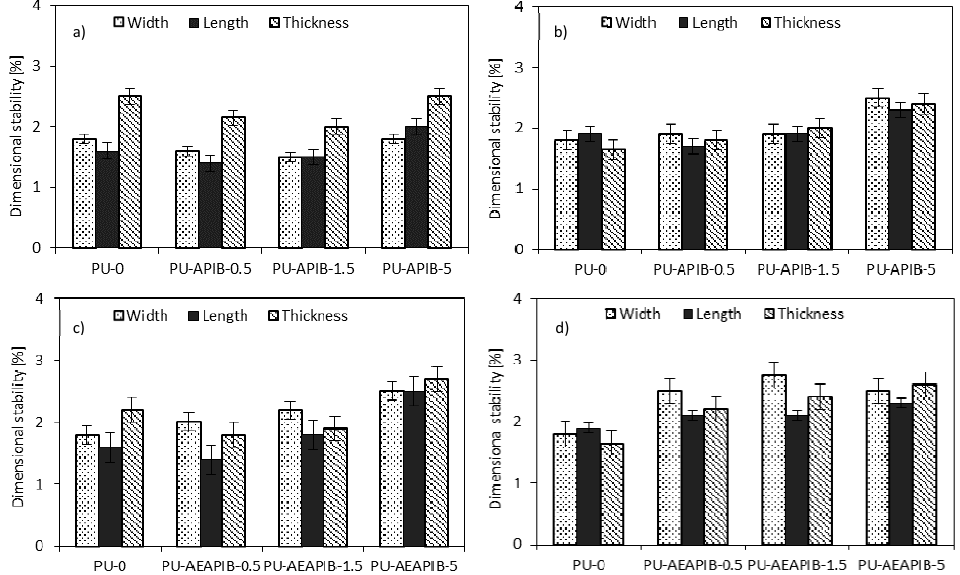
Figure 15. Dimensional stability of RPUFs modified with APIB-POSS ( a , b ) and AEAPIB-POSS ( c , d ) after exposure at 70 °C and − 20 °C, respectively.